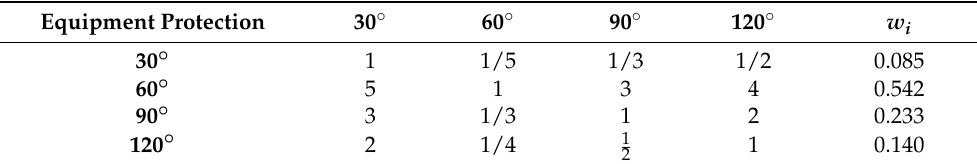
Table 16. Important degree judgment matrix of equipment protection under different wind attack angles.